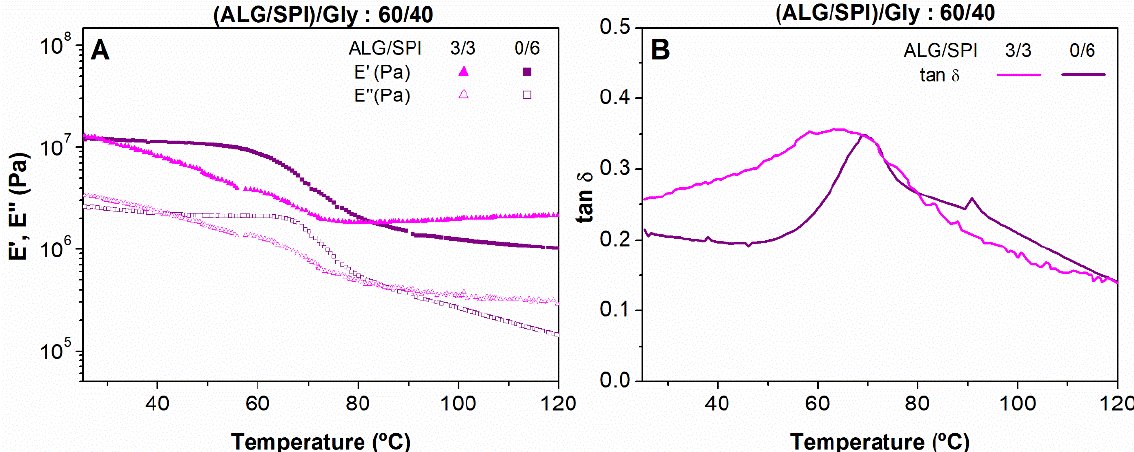
Figure 2. Evolution of the viscoelastic moduli ( A ) and loss tangent ( B ) with temperature of alginate + soy protein isolate/glycerol blends with ALG/SPI ratios: 0/6, 2/4, and 3/3, maintaining the ALG + SPI/Gly ratio of 60/40.